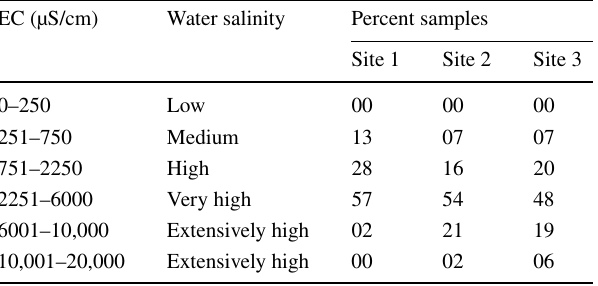
Table 11 Classification of water based on EC (Handa 1969) EC (µS/cm) Water